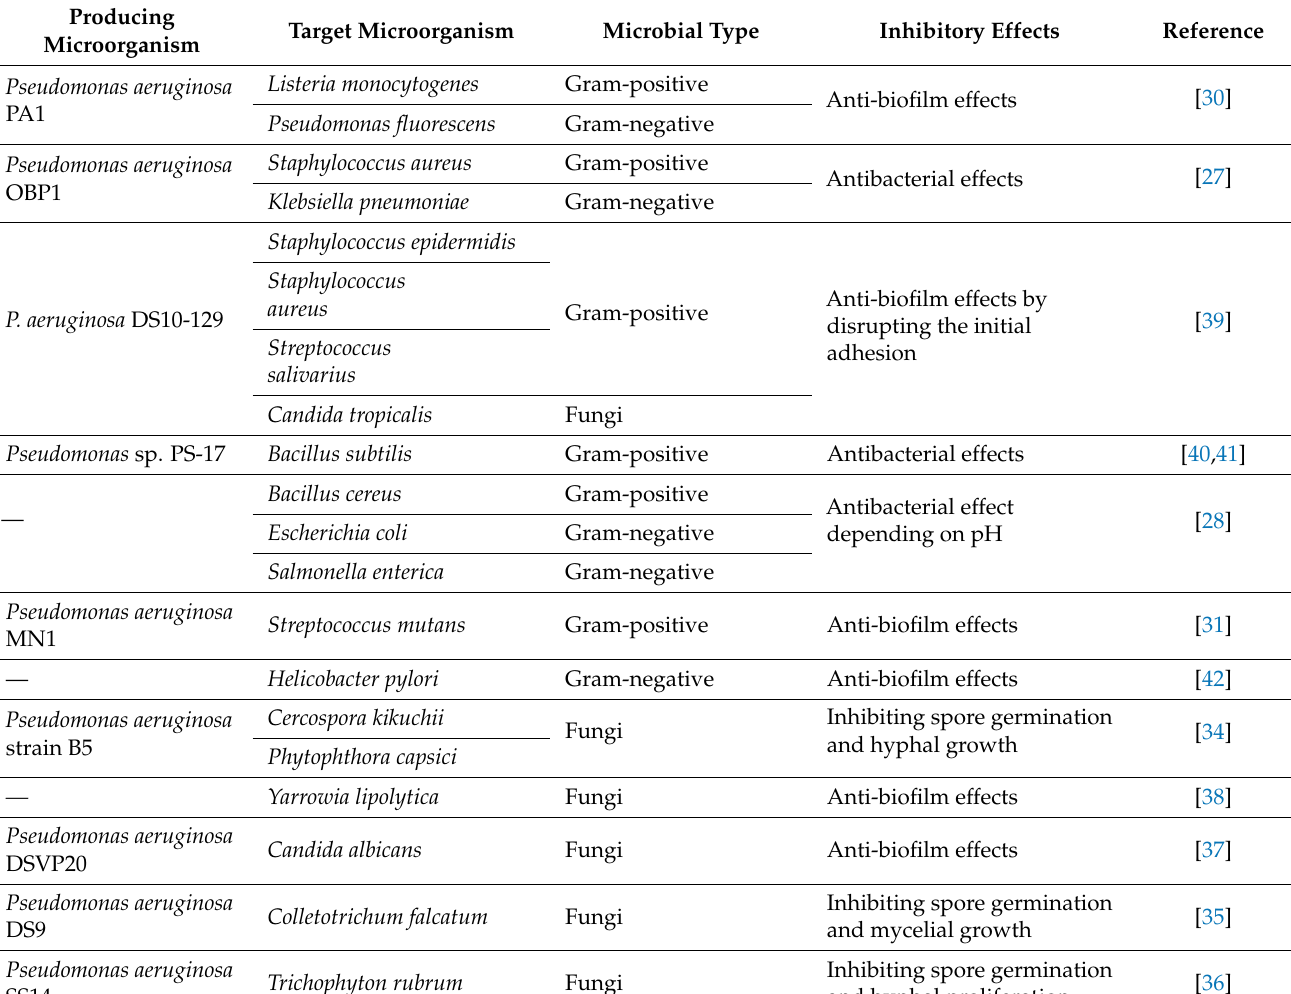
Table 1. Antimicrobial effects of rhamnolipids reported to